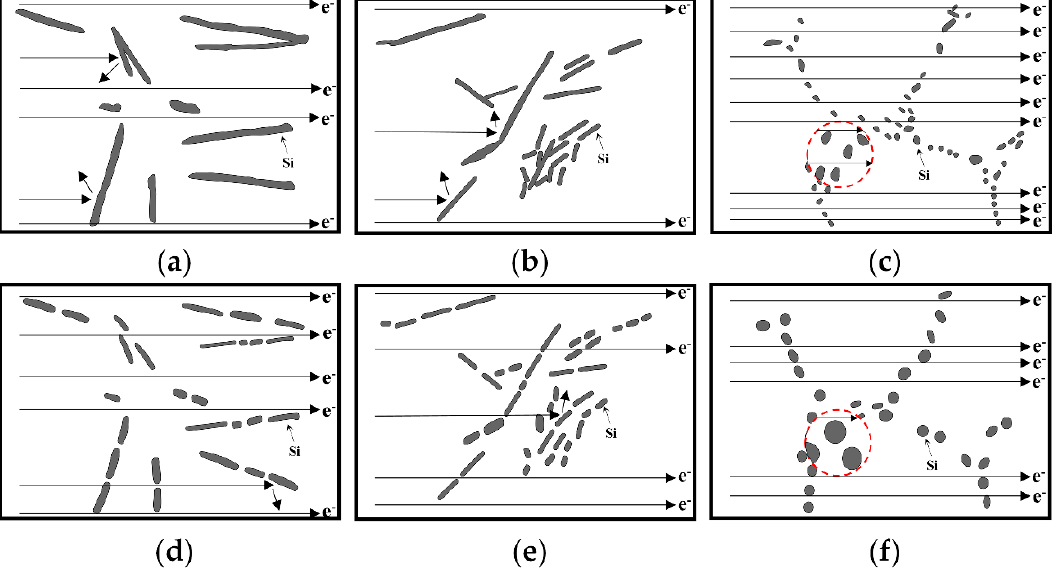
Schematic diagram of electron collision with eutectic silicon and electron transfer: ( a ) unmodified, ( b ) Sb modification, ( c ) Sr modification, ( d ) unmodified + T6, ( e ) Sb modification + T6, ( f ) Sr modification + T6.